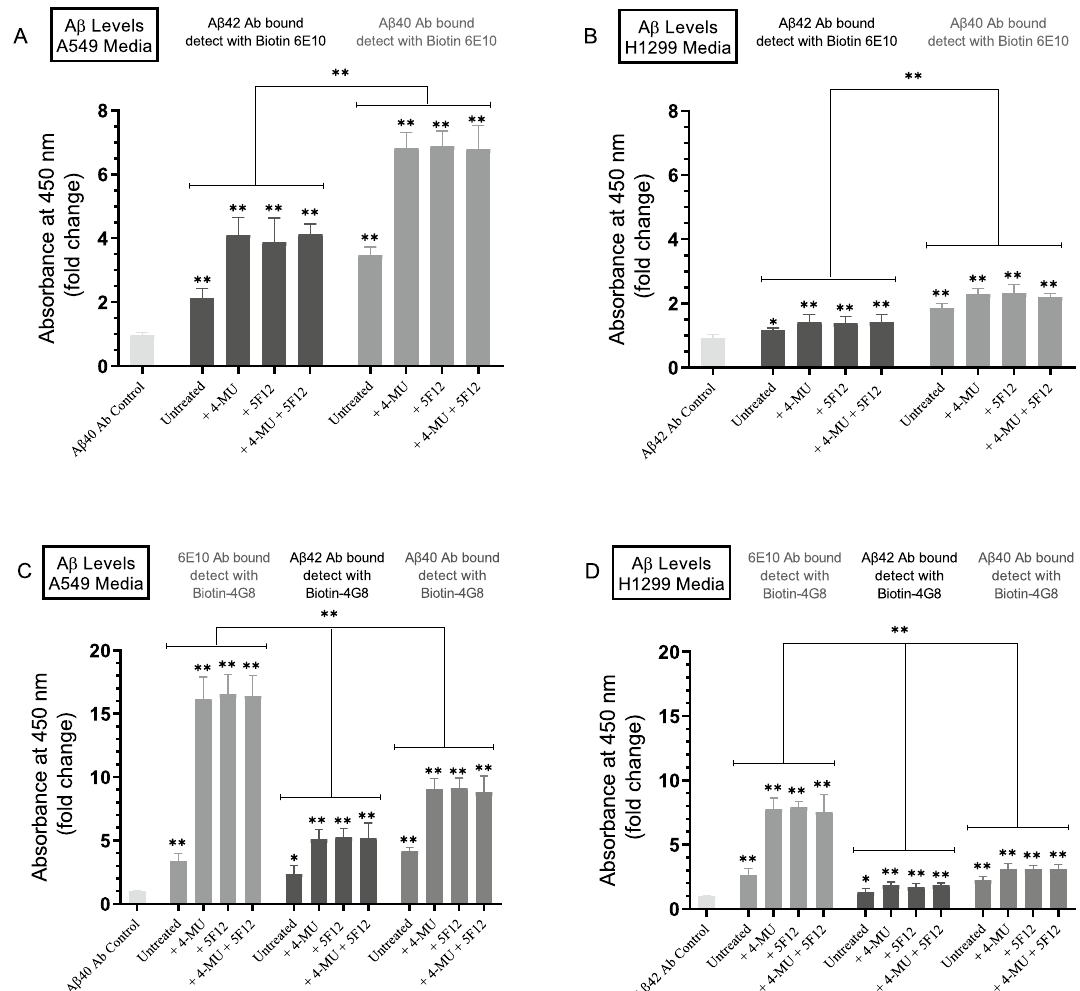
Figure 2. Higher levels of Aβ40 and Aβ42 are found in the media of A549 cells as compared to that of H1299 cells. Cells (0.2 × 10 5 ) were grown in 10% FBS-supplemented media for 24 h then incubated in serum-free media for 24 h and treated as indicated for 72 h with 600 µM 4-MU and/or the CD44 antibody (5F12, 5 μg/mL). The media was then collected and the same amount of protein (3 µL of 600 µg/mL total protein) of each sample was used to quantitate Aβ (“Methods” section) using the indicated antibodies. Data from five independent assays, each carried out in triplicate, were quantitated, averaged, normalized, and expressed as fold change relative to controls including all components but using 6E10 antibodies instead of biotin-6E10 ( A , B ) or 4G8 antibodies instead of biotin-4G8 (C, D) using the GraphPad 8.4.3 software. The graphs summarize the results expressed as means ± SD (n = 5). Asterisks (*) indicate a statistically significant difference from the corresponding negative control of each cell line, Mann–Whitney test. Statistical differences between different groups were analyzed by an ordinary one-way analysis of variance (ANOVA) followed by Tukey’s post-hoc multiple comparison test. * p < 0.05, ** p < cells to 4-MU resulted in upregulation of p53 79 and treatment of human chronic myelogenous leukemia cells, K562, with 4-MU was found to affect apoptosis by increasing p53 expression 80 .